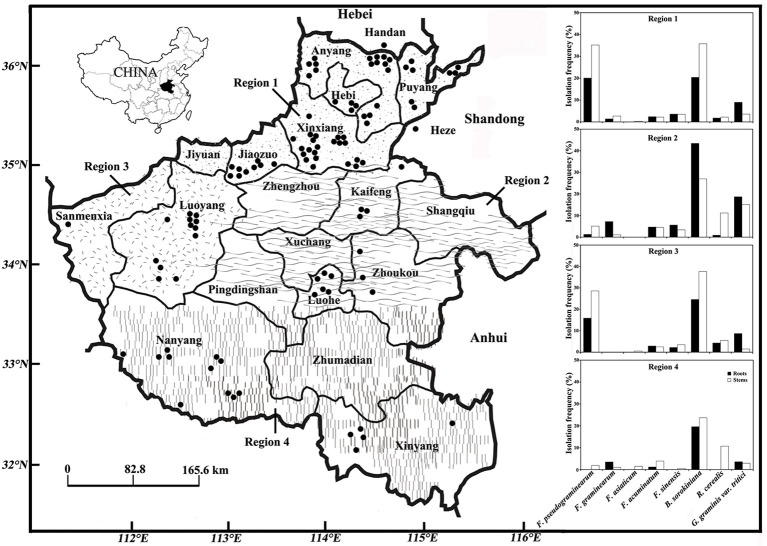
Isolation frequency of Fusarium spp., Bipolaris sorokiniana, Rhizoctonia cerealis, and Gaeumannomyces graminis var. tritici from symptomatic wheat roots and stems from the major wheat- producing areas in the North China Plain during 2013–2016. The area of scattered dots indicates the irrigated areas of northern Henan, southern Hebei and western Shandong (region 1) including Anyang, Hebi, Puyang, Xinxiang, Jiaozuo, Handan, and Heze; the area of wavy lines indicates the supplementary-irrigated areas of central Henan (region 2) including Kaifeng, Luohe, and Zhoukou; the area of dashed lines indicates the dry-farming areas of western Henan (region 3) including Sanmenxia and Luoyang; the area of vertical lines indicates the rain-fed areas of southern Henan (region 4) including Nanyang and Xinyang. The symbol “•”represents the sampling places of diseased wheat associated with root and crown rot fungi.